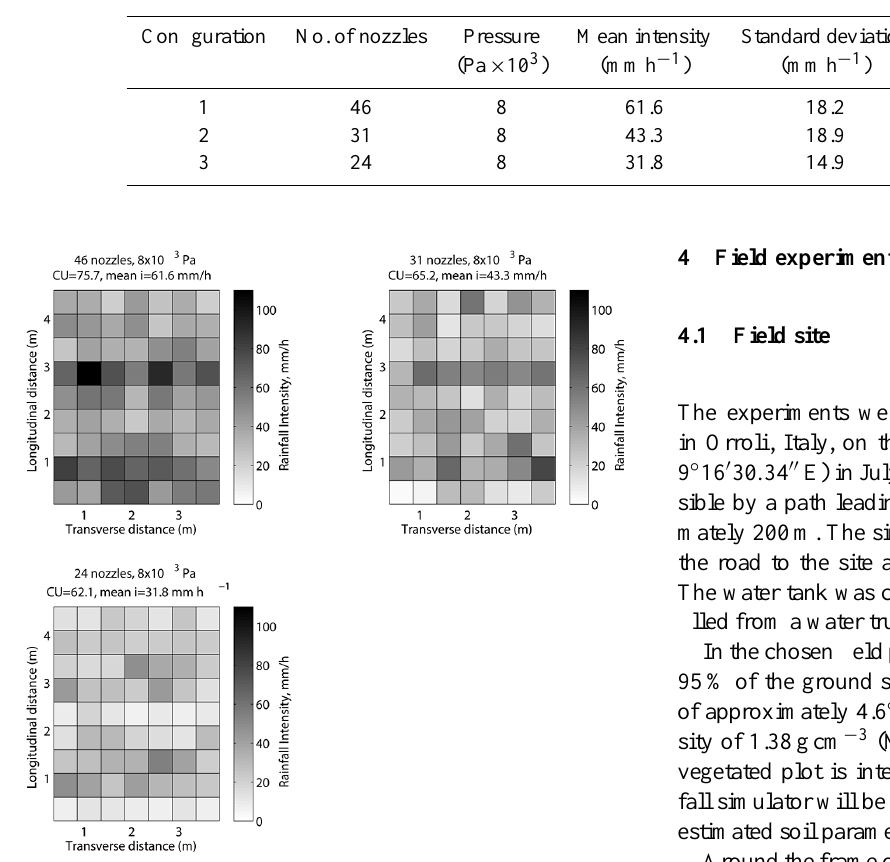
Figure 6. Distribution of rainfall intensities and coefficient of uni- formity for the three nozzle